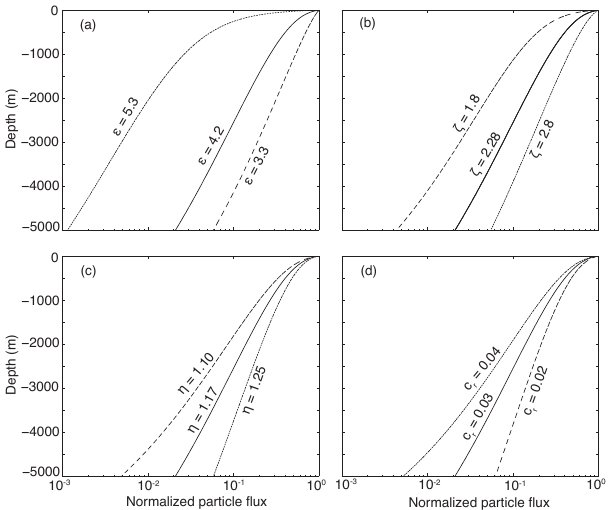
Figure 2. The sensitivity of the normalized particle flux pre- dicted by the Particle Remineralization and Sinking Model (PRiSM, Eq. 13) to the four parameters controlling the particle flux: (a) (cid:15) , the exponent in the relationship between particle size and particle size distribution, (b) ζ , the exponent in the relationship between parti- cle mass and particle size, (c) η , the exponent in the relationship between particle sinking velocity and particle size, and (d) c r , the degradation rate of sinking particles. Solid curves use the parame- ters from Fig.